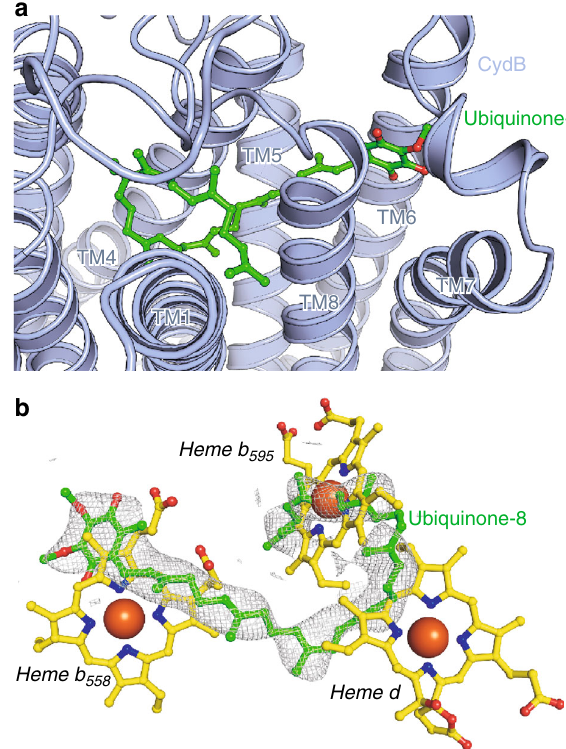
Fig. 5 E. coli bd oxidase features a Q-8 binding site in CydB that has a stabilizing function. a Ubiquinone-8 (shown as sticks) binds to subunit CydB (light blue). It deeply inserts into CydB, involving six TM helices in binding. b A superposition of CydA and CydB shows that in CydB, ubiquinone-8 follows the trace of the heme positions in